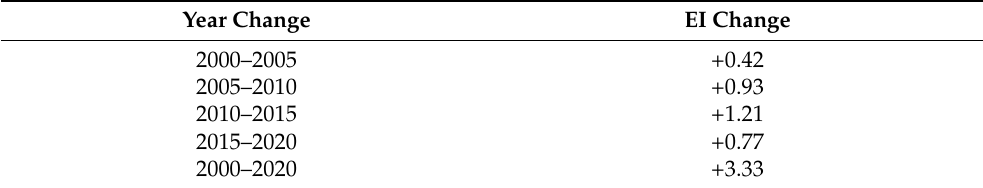
Table 11. Change in EI in Rangtang